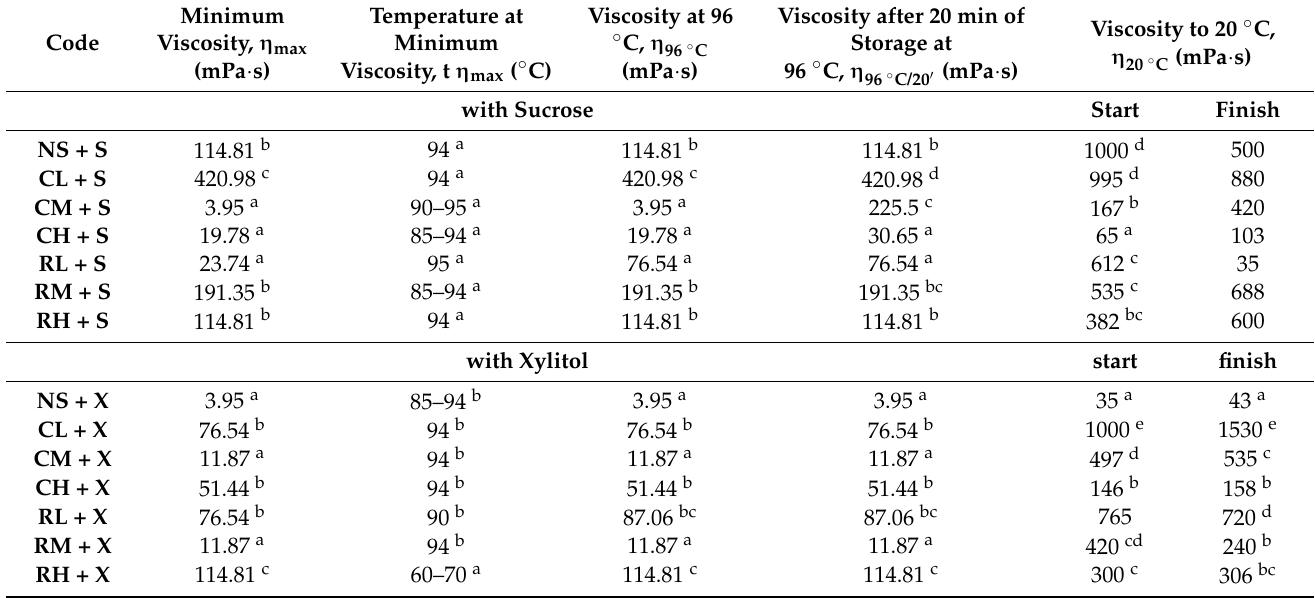
Table 1. Parameters of the viscosity change of blackberry jelly-like